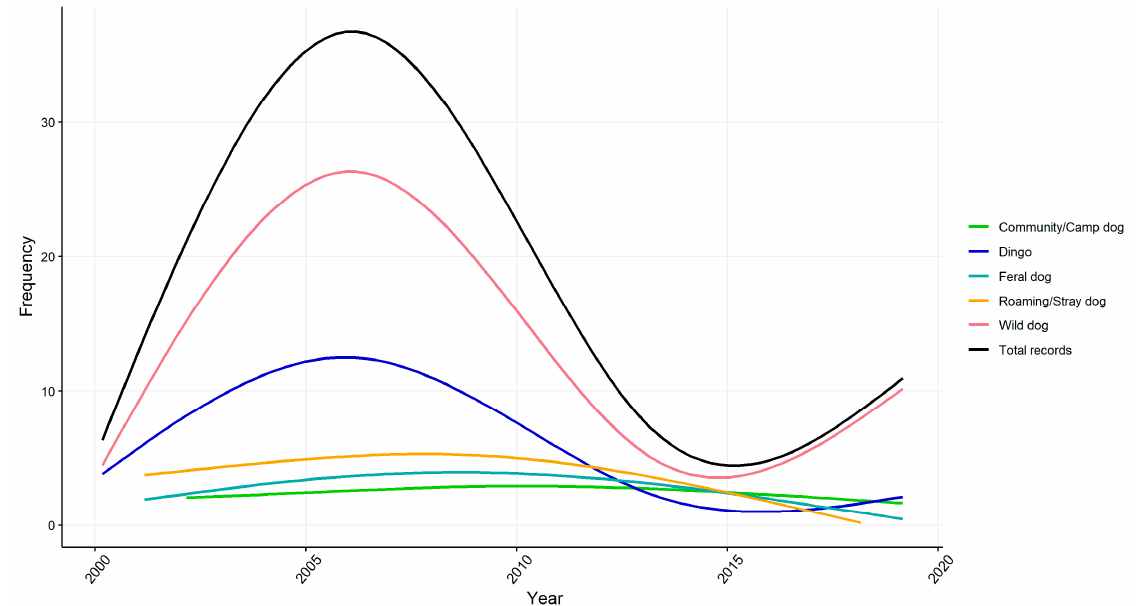
Figure 1. Frequency of articles (by reported dog type) in a study of Australian news sources from 2000 to 2019. Lines are smoothed using a generalised linear model of article counts for each year in order to show the general trend during the study period. Dogs were classified according to terminology used in the news sources.